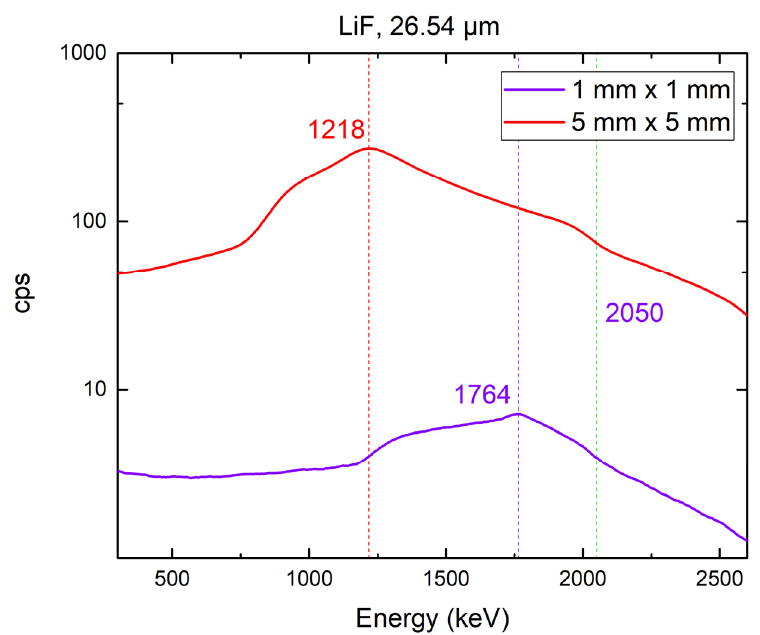
Figure 7. Comparison of the responses of 4H-SiC SBD detectors with different active areas (1 mm × 1 mm and 5 mm × 5 mm) equipped with a 26.54 µm thick 6 LiF thermal neutron converter layer to the neutron field of a JSI TRIGA reactor at 250 kW.